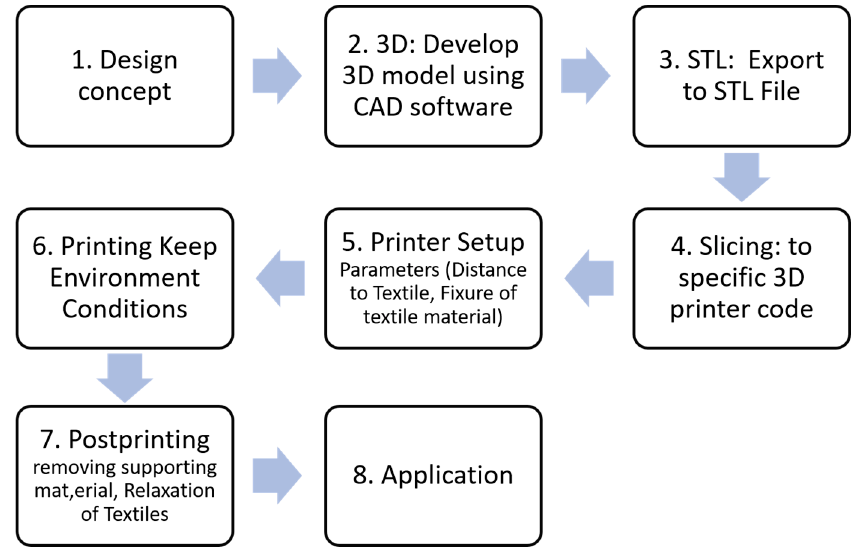
Figure 3. The 3D printing steps of textiles [35,67–69].